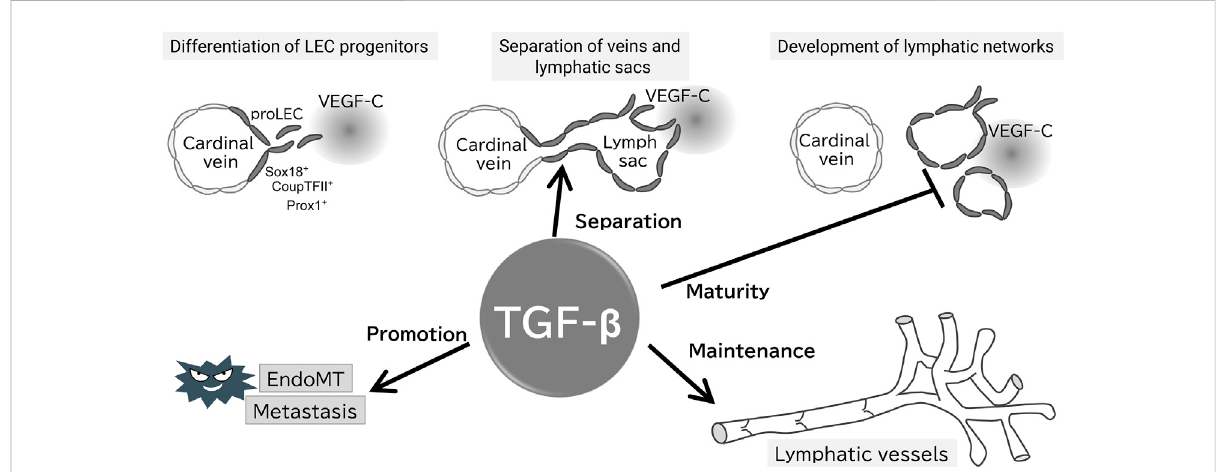
FIGURE 2 ProposedworkingmodelofTGF- β signalingintheformationandmaintenanceofthelymphaticsystem.Evidenceforthepresenceofeachstep of the proposed model is provided in the text; TGF- β does not affect the early development of lymphatic vessels, whereas is important for their separation from veins, maturation, and maintenance of lymphatic function. TGF- β also promotes tumor lymphatic metastasis via EndoMT of